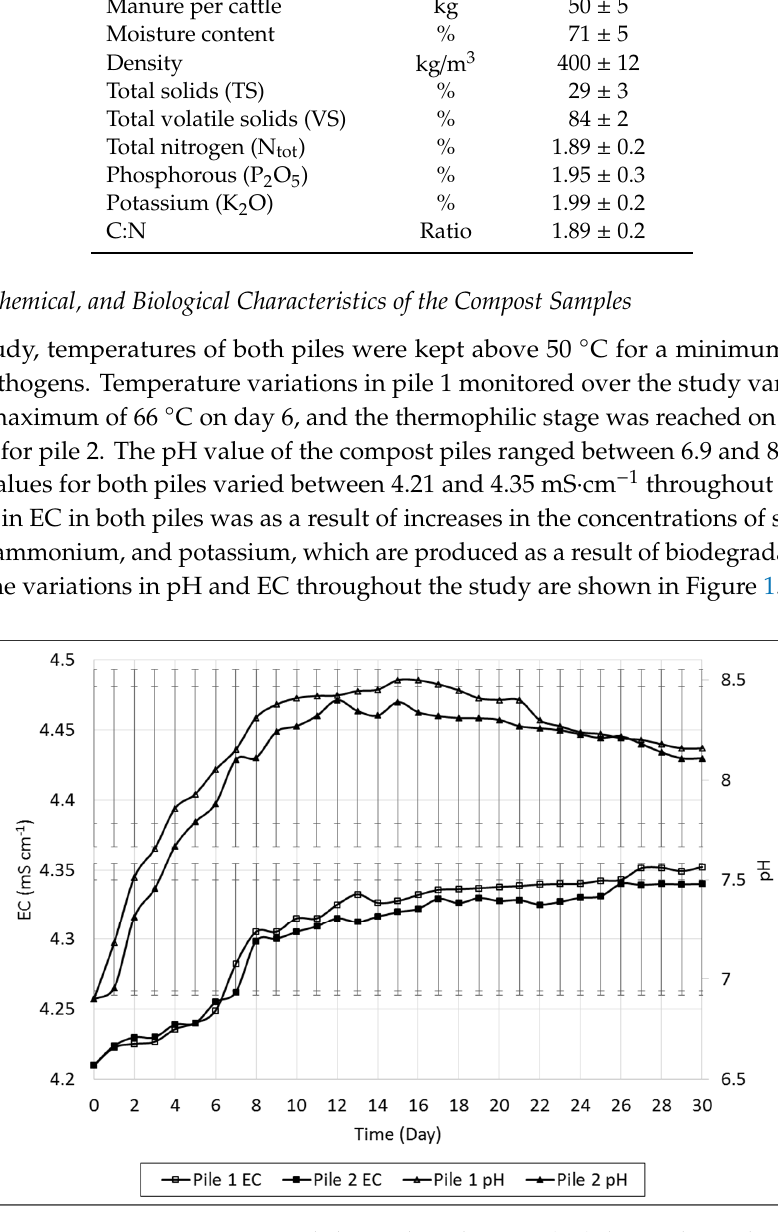
Figure 1. Variations in pH and electrical conductivity (EC) during the study .